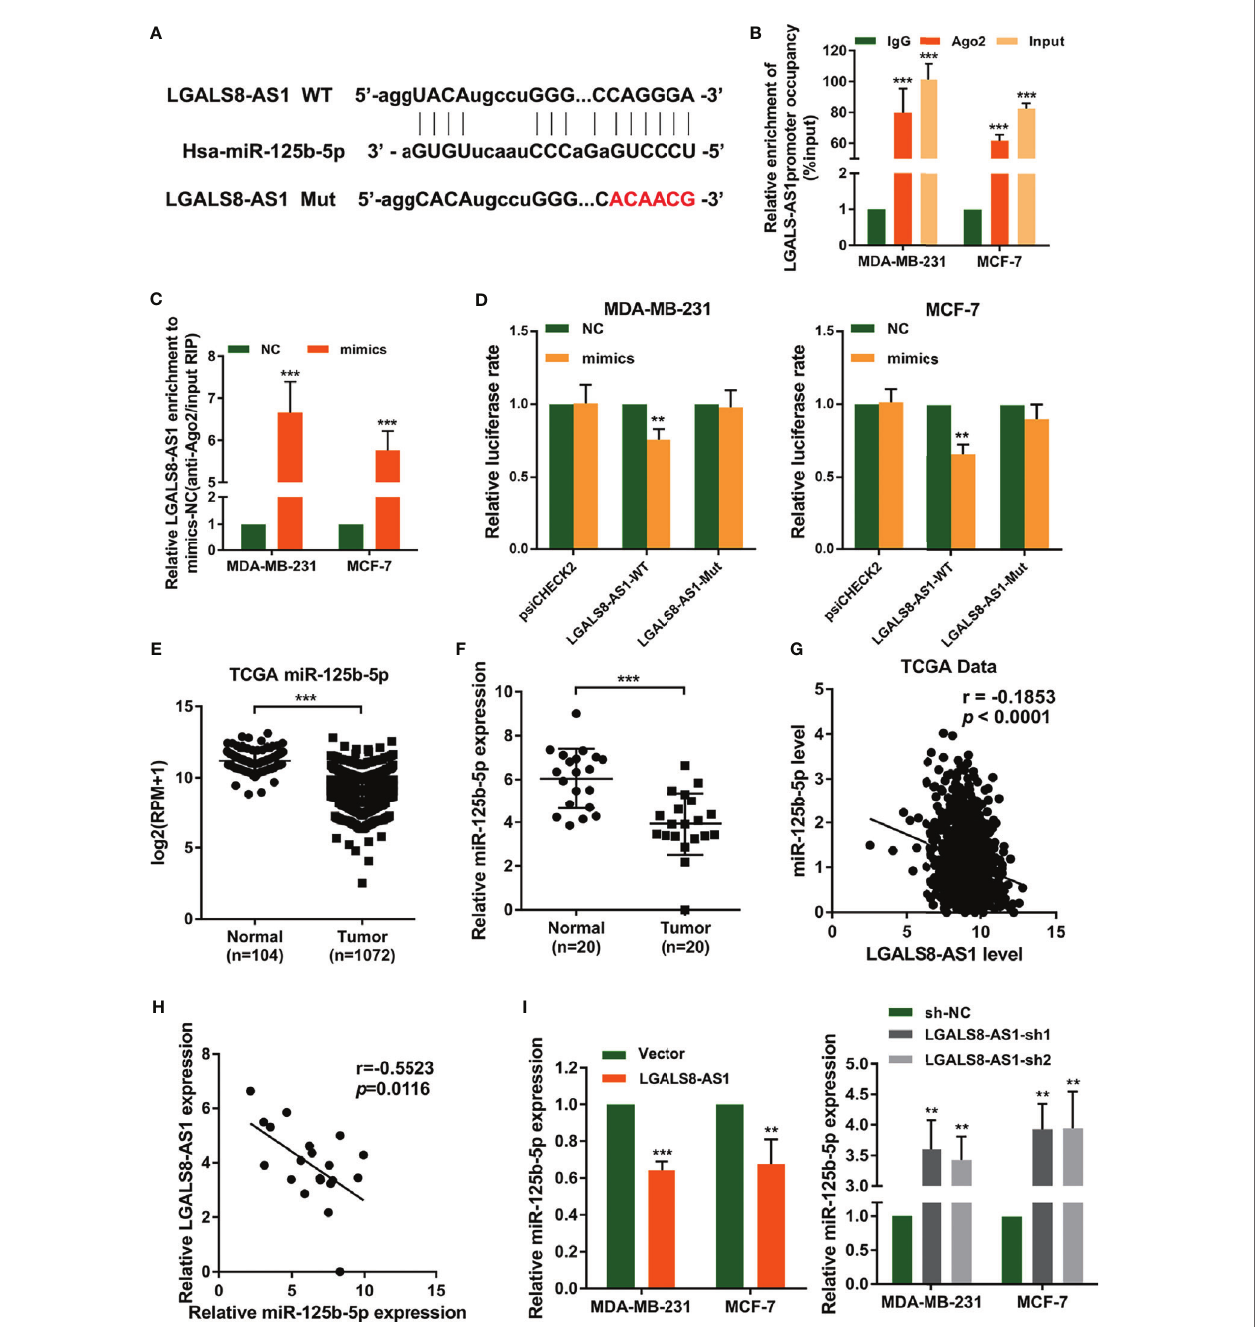
FIGURE 4 | LGALS8-AS1 acts as a sponge of miR-125b-5p in breast cancer. (A) Schematic diagram of the miR-125b-5p putative binding sites and mutant site in LGALS8-AS1 predicted by the LncBase database. (B, C) Relative enrichment of LGALS8-AS1 and miR-125b-5p associated with Ago2 in MCF-7 and MDA- MB-231 and MCF-7 cells detected using anti-AGO2 RIP (nonspeci fi c IgG as the negative control). (D) Luciferase activities in MDA-MB-231 and MCF-7 cells after co-transfection of the LGALS8-AS1 mutant or wild-type (WT) plasmid together with the miR-125b-5p mimics or miR-NC. (E) Expression of miR-125b-5p analyzed between tumor and normal tissues using the breast cancer gene (BRCA) dataset of The Cancer Genome Atlas (TCGA). (F) The expression of miR- 125b-5p was detected in breast cancer tissues and corresponding paracancerous tissues using real-time quantitative PCR (RT-qPCR). (G) Correlation between the expressions of LGALS8-AS1 and miR-125b-5p in TCGA BRCA dataset. (H) Correlation between the expressions of LGALS8-AS1 and miR-125b-5p in clinical breast cancer tissues. (I) Effect of LGALS8-AS1 knockdown or overexpression on the expression of miR-125b-5p detected in MDA-MB-231 and MCF-7 cells by RT-qPCR. ** p < 0.01, *** p <